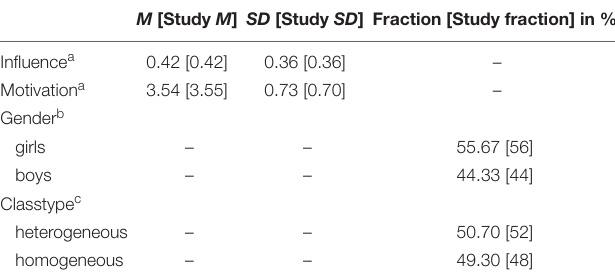
TABLE 7 | Population characteristics and values reported by Maulana et al. (2013).